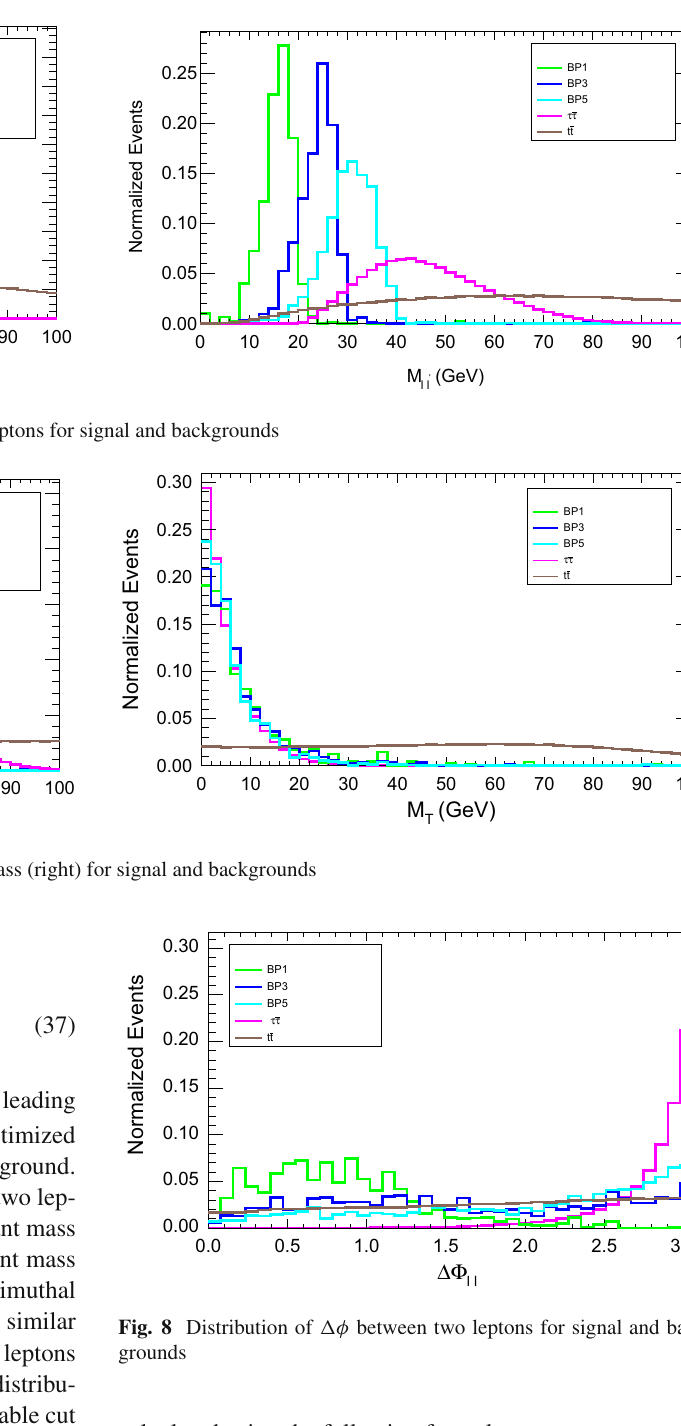
calculated using the following